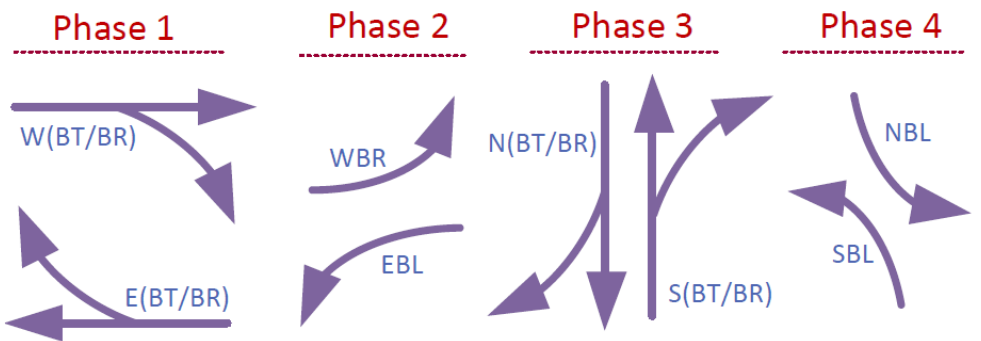
Figure 5. Four major signal phases. Left turns of phases 2 and 4 are protected and there are permissive left turns associated with phases 1 and